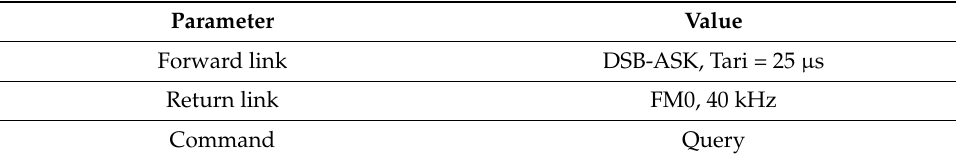
Table 13. Configuration of parameters of ISO/IEC 18000-63 protocol.